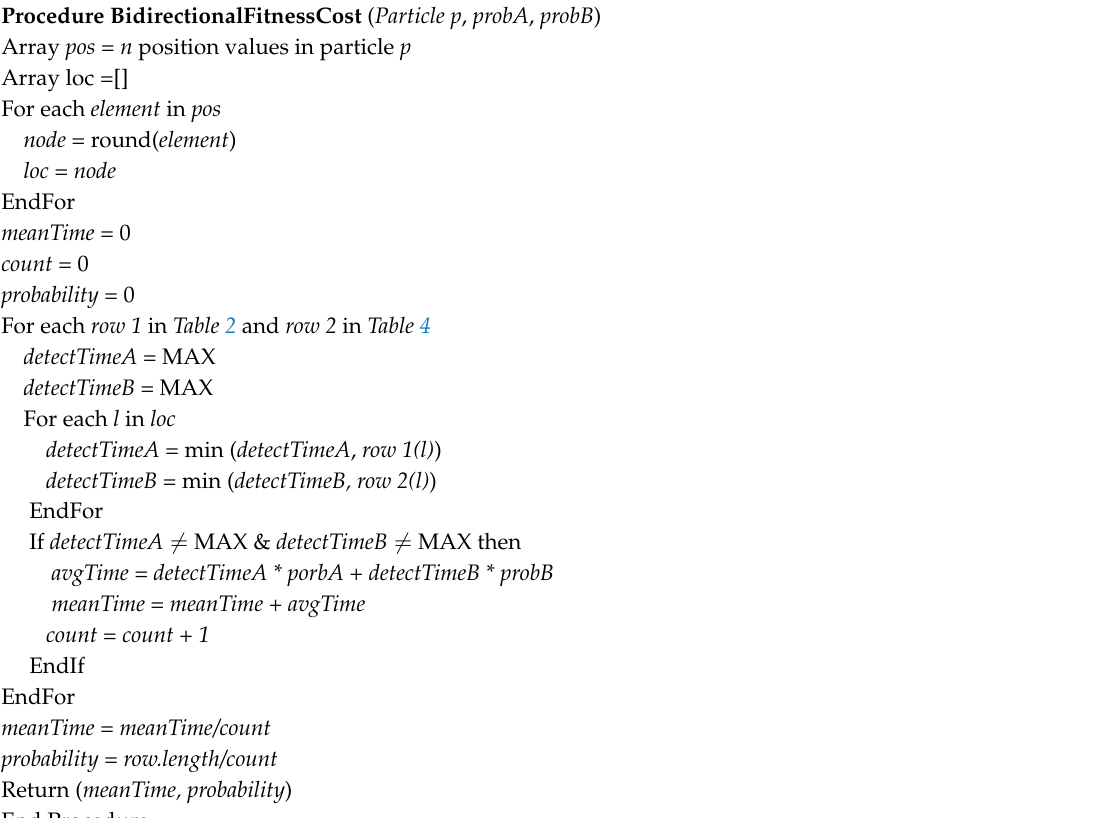
Algorithm 3 Pseudocode of Bidirectional Fitness Function